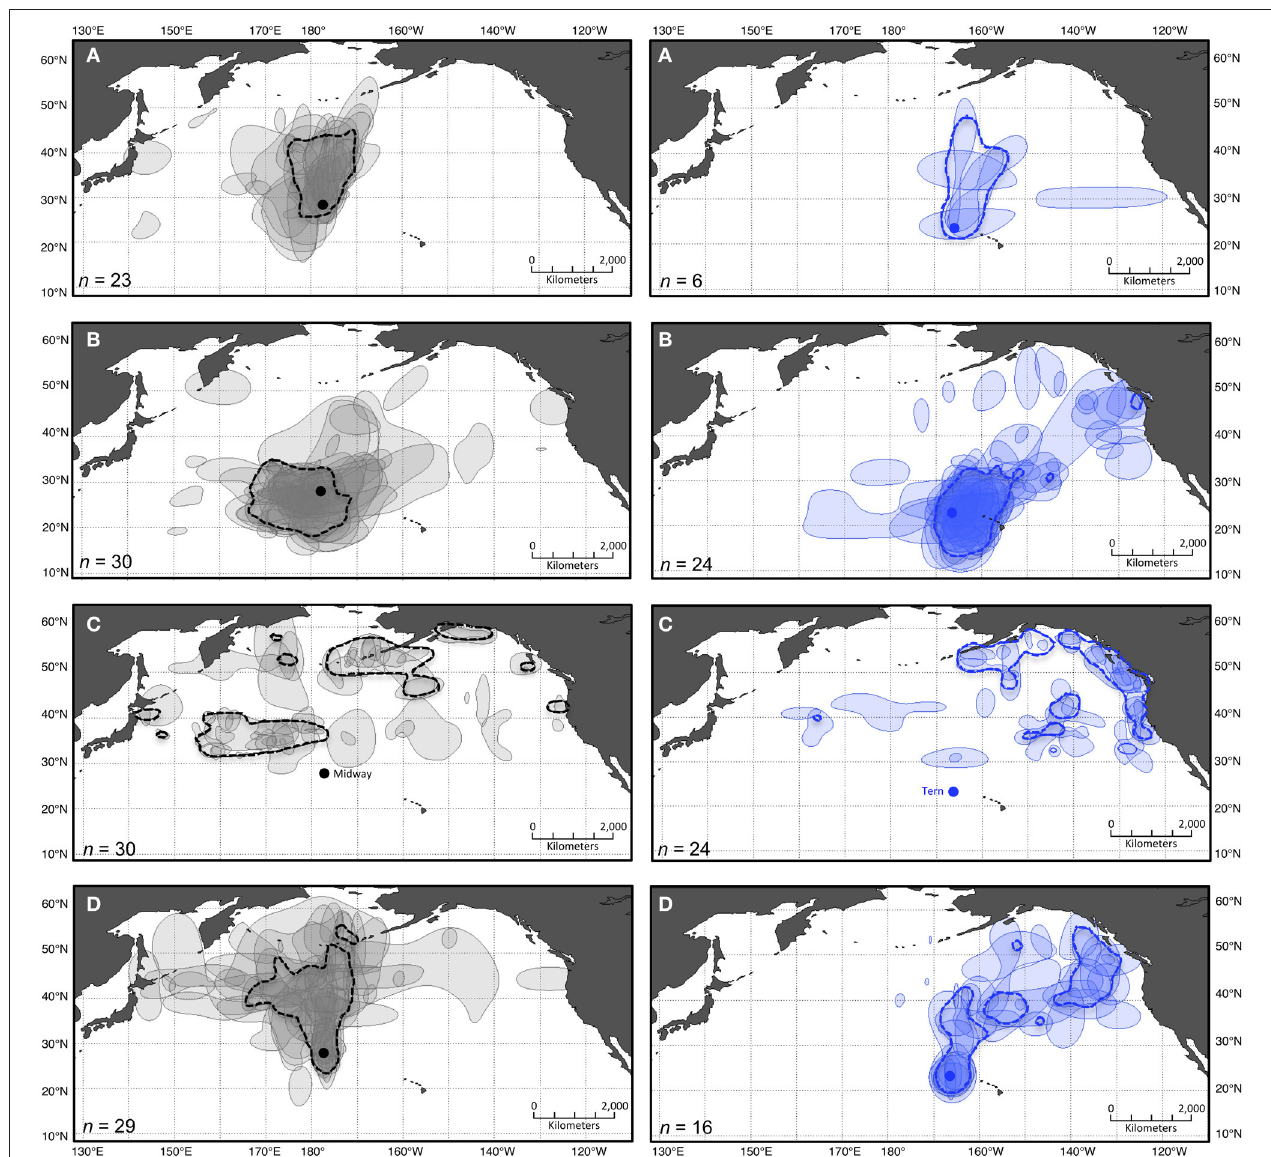
FIGURE 3 | Pooled and stacked 50% kernel contours for two colonies of black-footed albatross during four periods of the annual cycle. Dashed polygons show 50% kernel contours from pooled KDE including GLS location data from all individual black-footed albatross tracked from Midway (left in gray) and Tern (right in blue) during four periods of the annual cycle: (A) ECR, (B) LCR, (C) OW, and (D) PBE (see Figure 1 ). Shaded polygons show 50% contours from individual KDE including data from each bird independently. The lightest shade indicates areas used by a single individual, and the darkest indicates areas of most intense overlap among individuals. Colonies are indicated in panels (C) by solid circles in their respective colors (projection: Lambert Cylindrical Equal Area, datum: